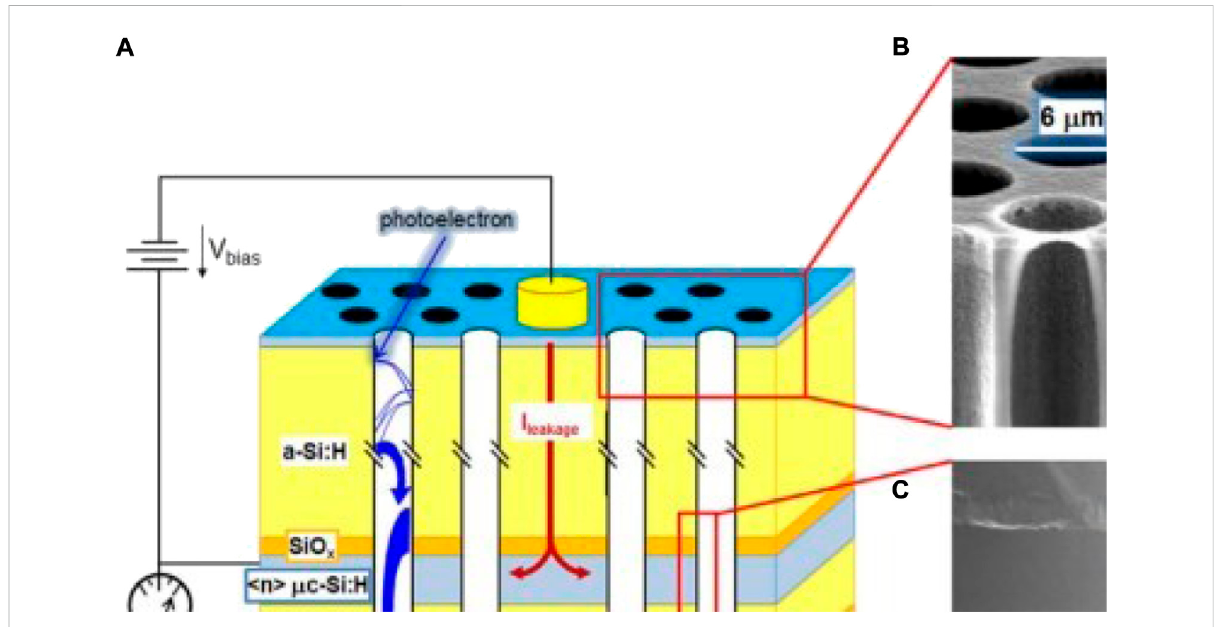
FIGURE 8 Schematicview of theAMCP architecture (A) . A bias voltage of up to 600 V is applied between the top electrode and theintermediateone.The AMCPsignalisrecordedontheanode(bottomelectrode).Athina-Si:Hlayerisusedtodecouple(isolate)theanodefromtheintermediateelectrode. Cross-sectionalSEM imagesofthetop ofanAMCP,showingthecurrentchannelgeometries,andthebottomlayers areshownin (B,C) .Imagetaken from [35].